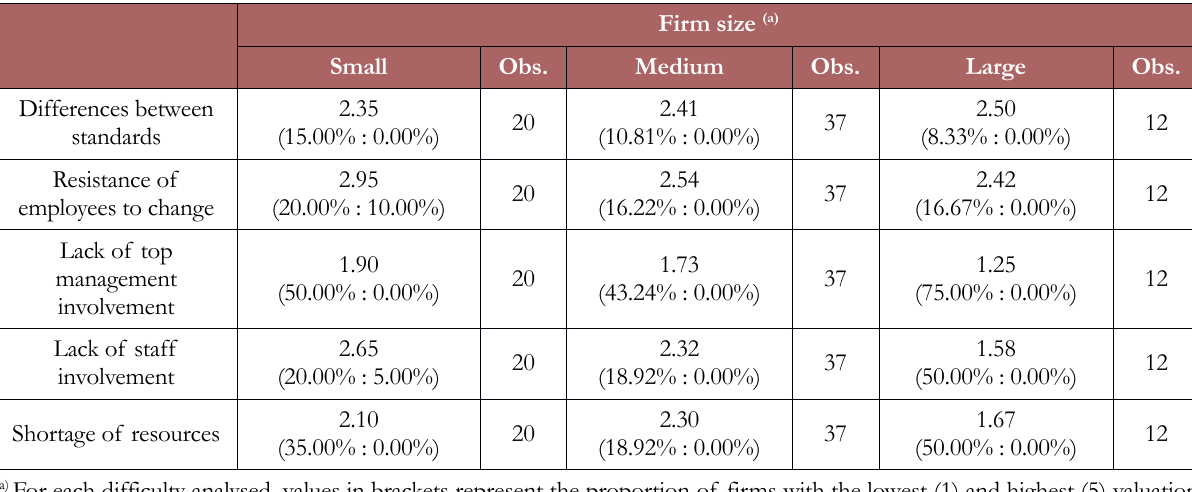
Table 5. Descriptive statistics for the difficulties according to the firm